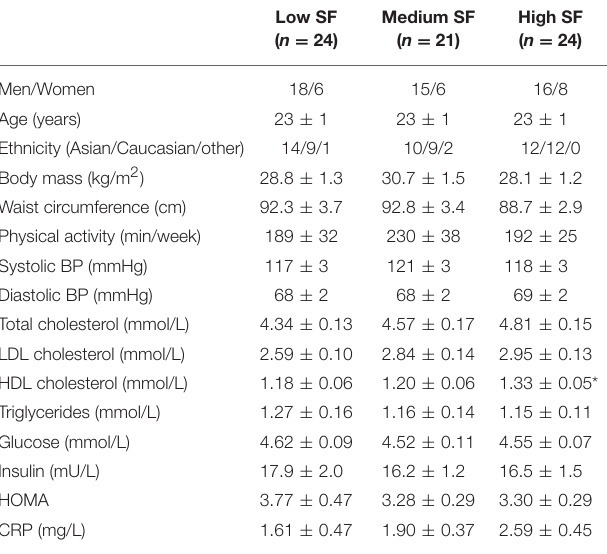
TABLE 1 | Participant